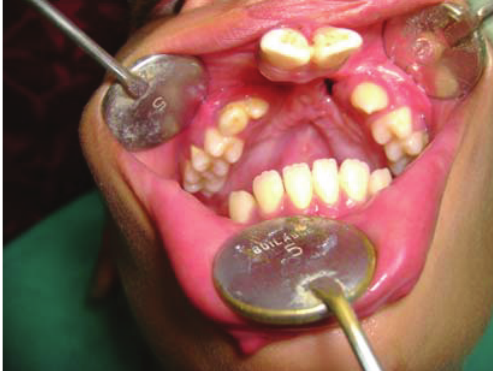
Figure 2: Intraoral view showing bilateral alveolar clefts in premaxillary region.